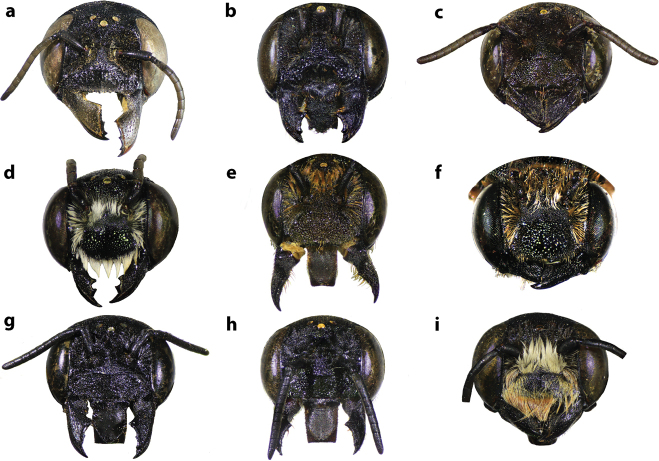
Frontal view of some Thai Callomegachile (a–c, e, g, h females, d, f, i males) aM. (Callomegachile) atratiformisbM. (Callomegachile) chiangmaiensis sp. nov. c, dM. (Callomegachile) disjunctae, fM. (Callomegachile) facetagM. (Callomegachile) fulvipennishM. (Callomegachile) impressaiM. (Callomegachile) memecylonae.